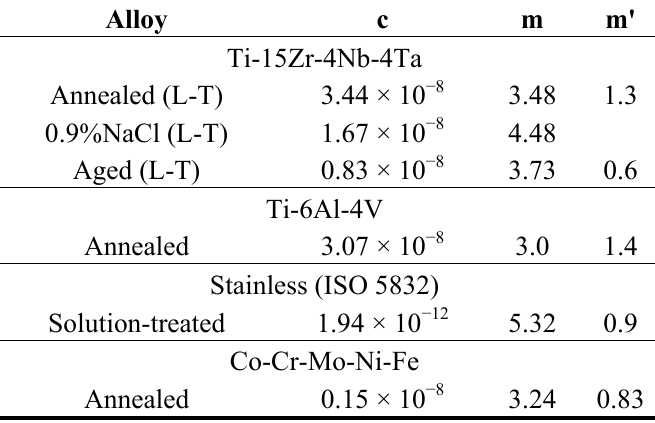
Table 5. Comparison of m and c obtained by fatigue crack growth test (L-T) of various